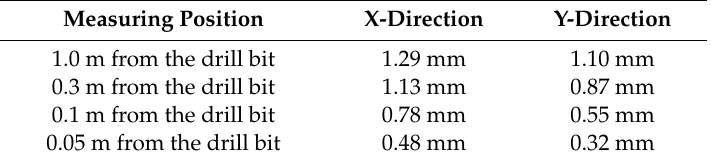
Table 7. Lateral displacement of BHA under di ff erent positions in